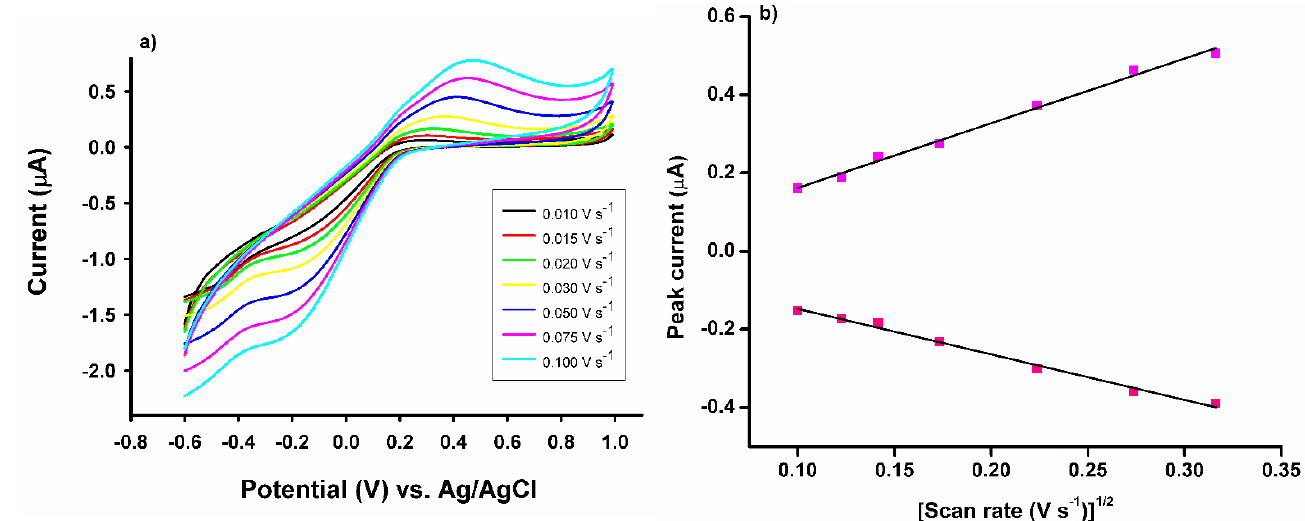
Figure 3. ( a ) CVs in a solution of 5.0 × 10 − 3 mol L − 1 K 3 [Fe(CN) 6 ] (0.1 mol L − 1 KCl) at various scan rates ranging from 0.010 to 0.100 V s − 1 using the PIX/AuNPsnGr sensor (working conditions: potential range from − 0.6 to 1.0 V; step potential 0.025 V). ( b ) Dependence of the peak current on the square root of the scan rate for the PIX/AuNPsnGr sensor .